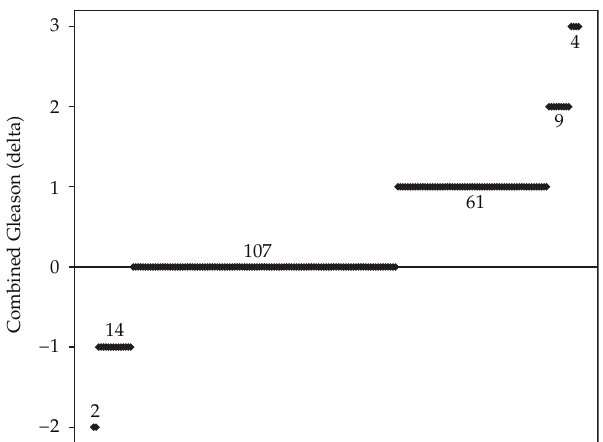
Figure 8: Biopsy versus pathology Gleason score. The di ff erence between the Gleason score as measured from a biopsy of the tumor relative to the pathological assessment of the score using the radical prostatectomy surgical specimen (cid:2) y -axis (cid:3) . The x -axis represents the sample index.